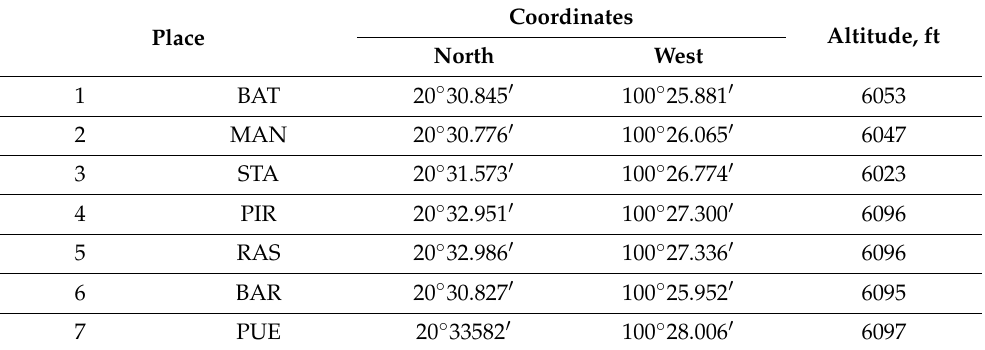
Table 1. Coordinates of the sampled sites.